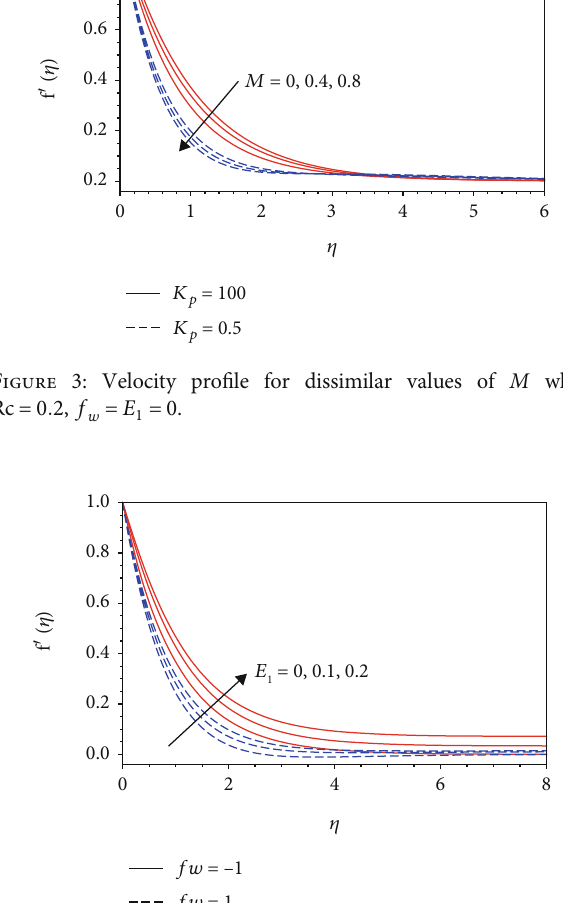
Figure 4: Velocity pro fi le for di ff erent values of E = 100 M = 1, and K p